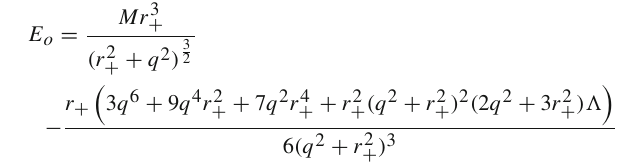
increasing at slow rate. When T = 0 . 16, the Gibbs free energy increasing rapidly and temperature bounces back for the − 0 . 02 ≤ σ ≤ 0 . 02. The effective temperature for the RBH with cosmological constant is also found to be T ef f = T − 4 σ = 1 . Now we will discuss the pres- 4 π r + sure for the RBH with cosmological constant at the